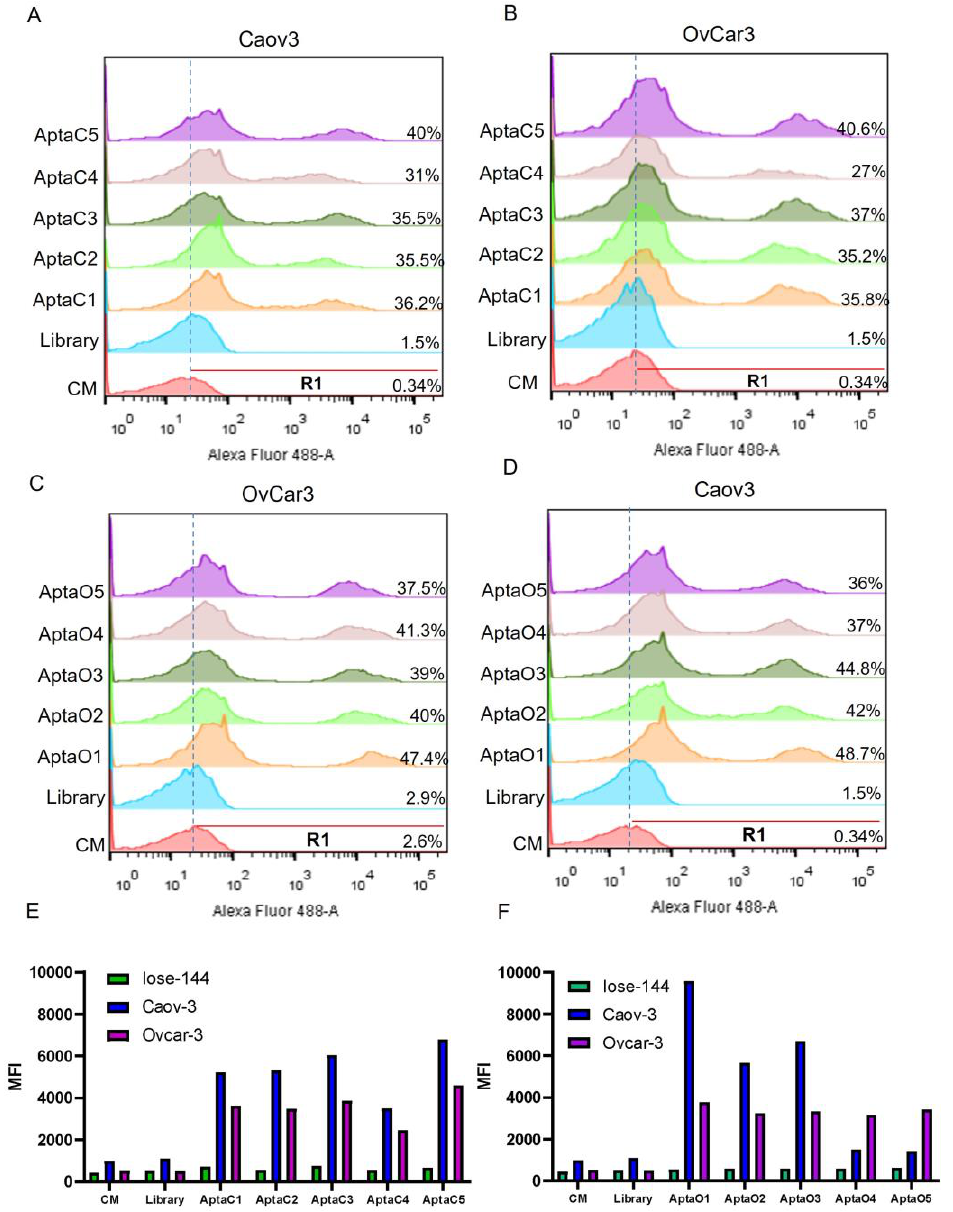
Figure 2. Specificity evaluation of the five most abundant individual aptamers in the last round. Labeling Intensity of the five individual aptamers selected for Caov-3 AptaC1, AptaC2, AptaC3, AptaC4, and AptaC5 in: ( A ) Caov-3 cells, and ( B ) Ovcar-3 cells. Labeling Intensity of the five individual aptamers selected for Ovcar-3: AptaO1, AptaO2, AptaO3, AptaO4, and AptaO5 in ( C ) Ovcar-3 cells and ( D ) Caov-3 cells. Graph demonstrating the Median Fluorescence Intensity (MFI) of the five individual aptamers selected for ( E ) Caov-3 and ( F ) Ovcar-3 in Iose-144 non-tumor control cells and Caov-3 and Ovcar-3 tumor cells. Negative controls correspond to culture medium (CM) and unbound unspecific aptamers from the first round of selection (Library).